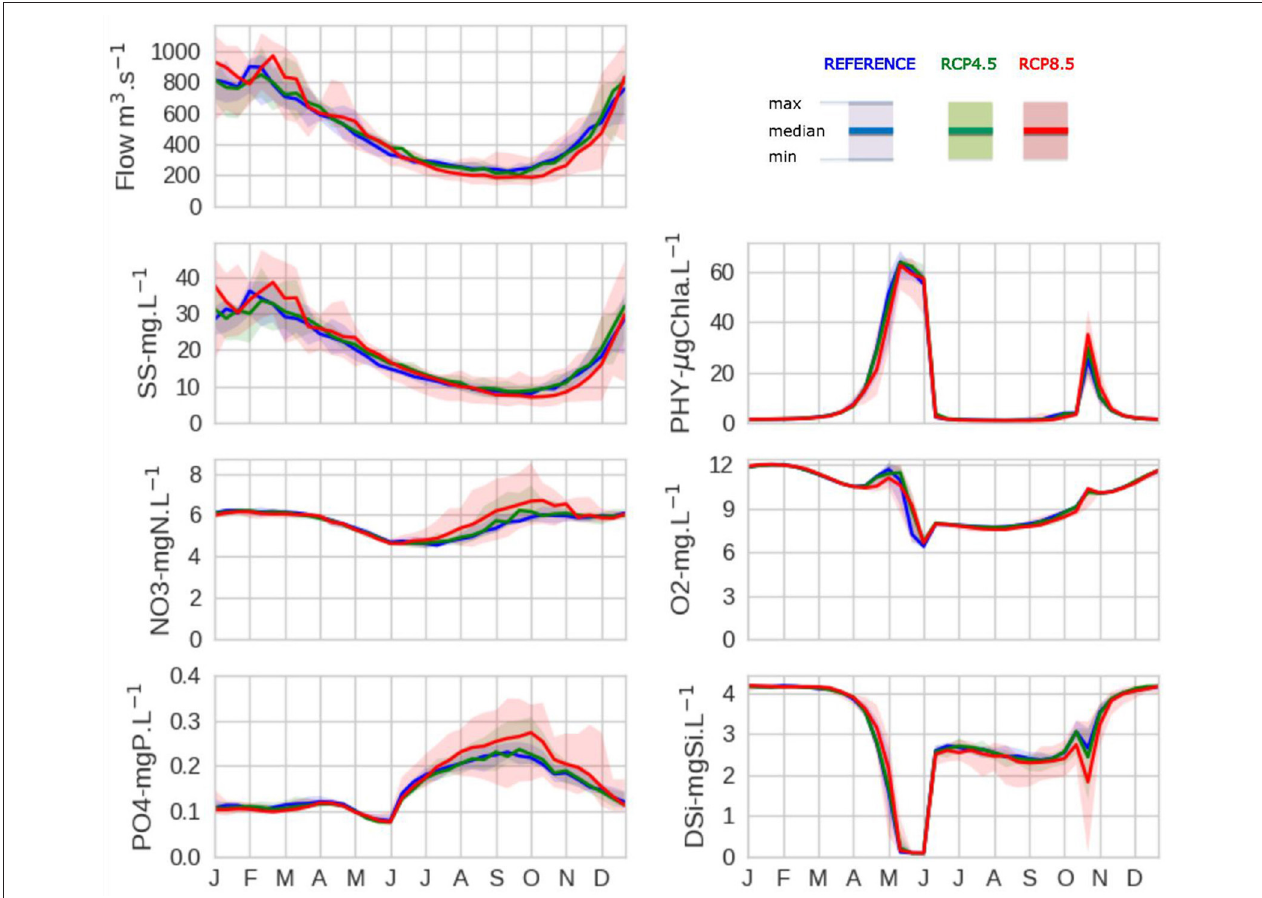
FIGURE 4 | Seasonal hydrological impacts of climate change and its consequences on hydro-biogeochemical variables (streamflow, suspended solids, nitrate, phosphate, phytoplankton, dissolved oxygen, silicic acid) at the outlet of the Seine River basin, averaged for the six climate projections and over 21 years (1980–2000 or 2080–2100). Median (line), minimum, and maximum values (envelopes) of the median projection values of the reference situation (blue) is compared to RCP4.5 (green) and RCP8.5